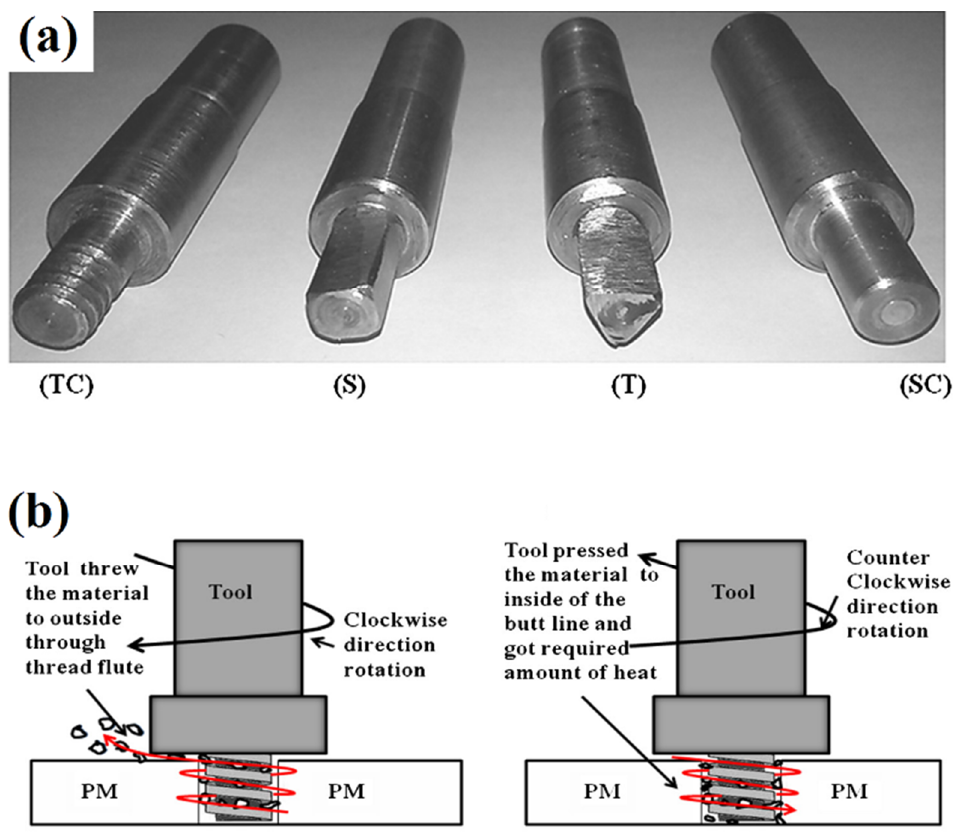
Figure 17. Different pin profile that used for LFSW of ( a ) polypropylene PP, polyethylene PE [43] and ( b ) ABS [57].